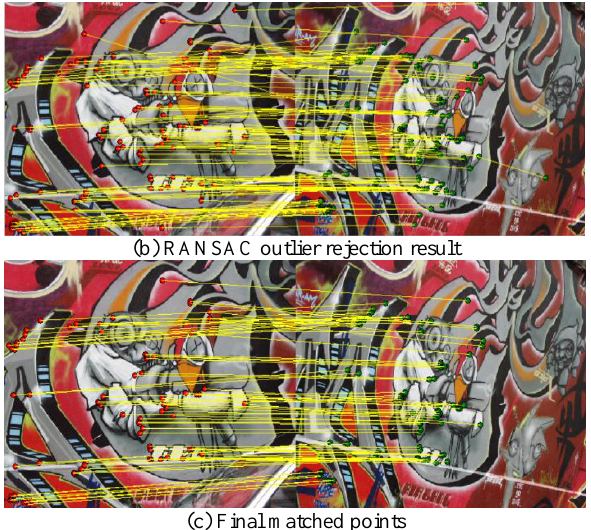
Figure 6. Outlier rejection for the fourth data set